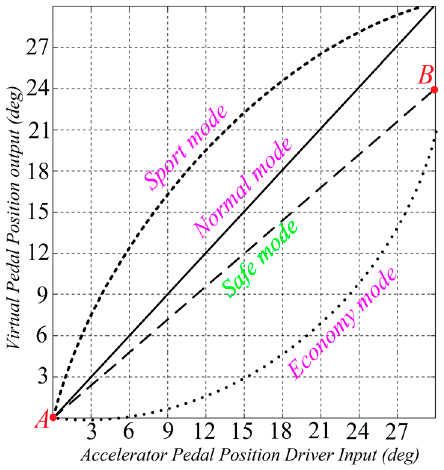
Figure 6. The proposed APSA scheme.